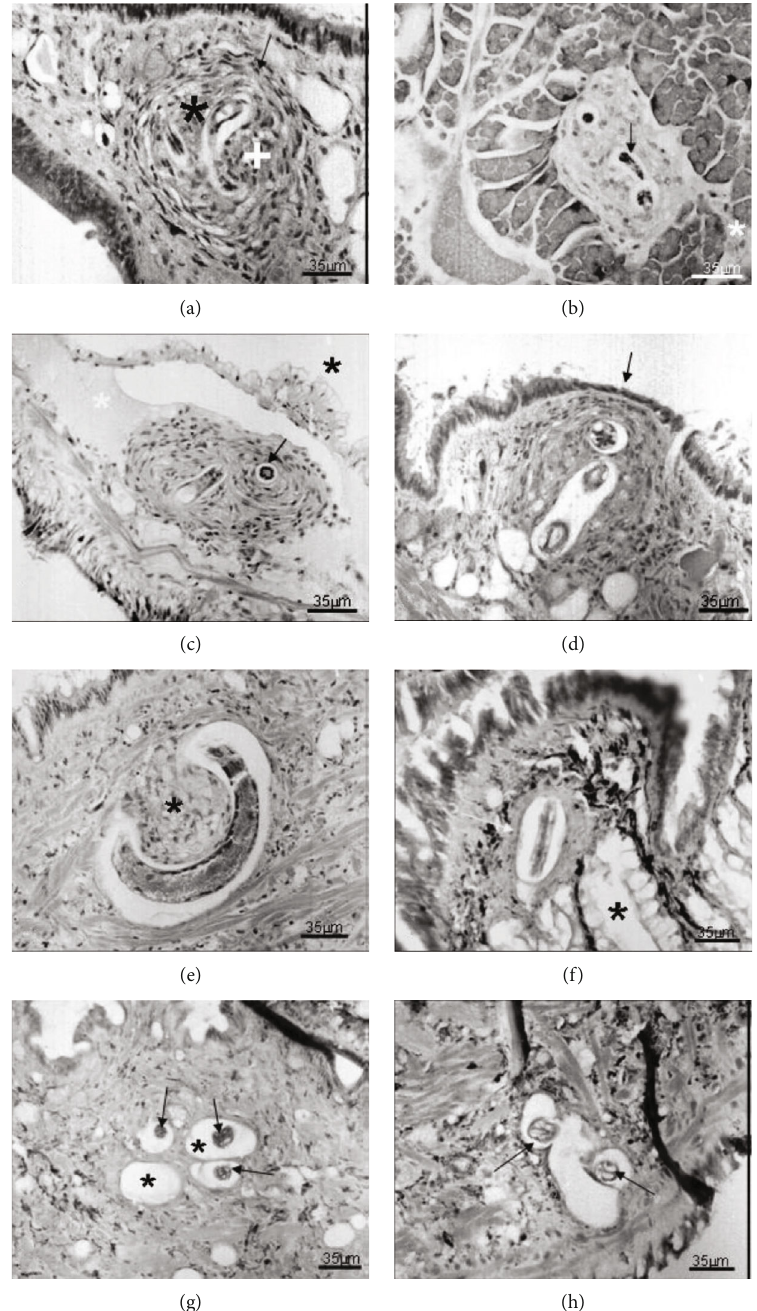
Figure 3: Histological sections of Biomphalaria glabrata infected with 1000 L1 of A. vasorum . Hematoxylin and eosin staining. (a) Granuloma formation of two distinct layers, an internal with cells of epithelioid aspect (black asterisk) and outer, with cells like fi broblast (arrow). The white cross shows the formation of the cell button on the one side of the larva after six days of the beginning of infection; (b) detail of the larva (arrow) within the albumen gland being surrounded by a cell reaction; the white asterisk shows the cell reaction present six days after the beginning of infection; (c) granuloma formation within the renal artery (white asterisk) fourteen days after the beginning of infection. Renal space is represented by the black asterisk, and the larva indicated by the arrow is an L2 because this has granules around the intestine (14 days); (d) granuloma in the dorsalis pedis region determining a thinning of the epithelium (arrow) fourteen days after the beginning of infection; (e) larva in the foot fi bromuscular tissue with a strong reaction in the form of button (black asterisk) without typical presentation of granuloma around, after twenty days of the beginning of infection; (f) larva (white arrow) in a less typical granuloma located in the conjunctive tissue around the kidney (black asterisk) thirty days after the beginning of infection. (g) Weak cellular reaction around the larva with looser appearance. It can be observed larvae within mucus cells (black asterisk) thirty days from the beginning of infection; (h) larvae located in foot fi bromuscular tissue without presenting typical granulomatous response, keeping the space even more clear after thirty days at the beginning of infection. Magni fi cations: (a – h) 35 μ